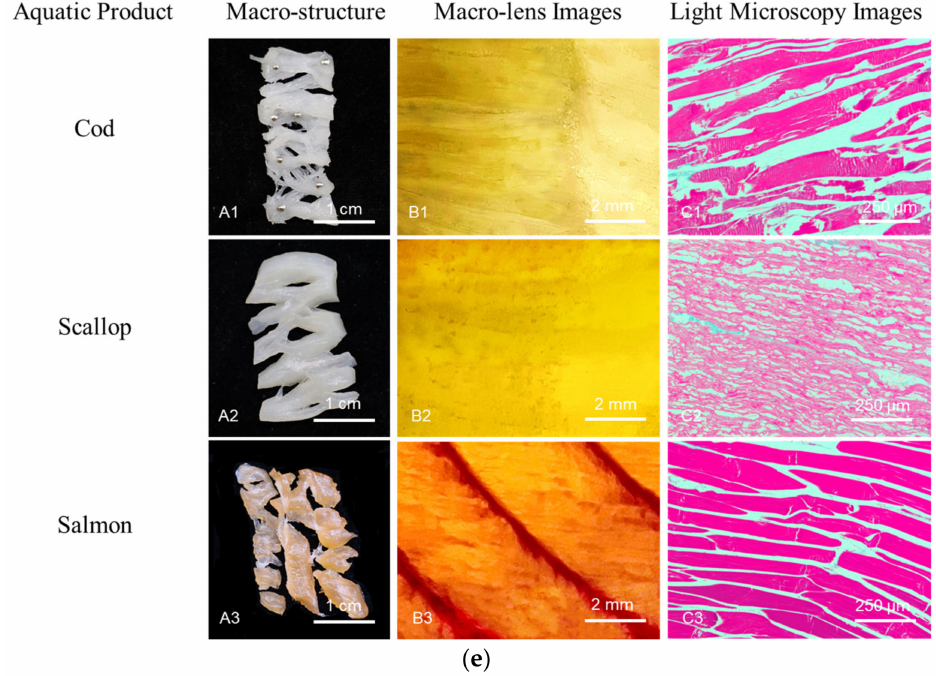
Figure 3. Macro-structure images, macro-lens images, SEM images, and cross-section views of samples under different test conditions: ( a ) moisture content, ( b ) extrusion temperature, ( c ) screw speed and ( d ) cooling die unit temperature; ( e ) macro-structure images, macro-lens images, and light microscopy images of three aquatic products. The flow direction is from right to left. The muscle fibers are in the horizontal